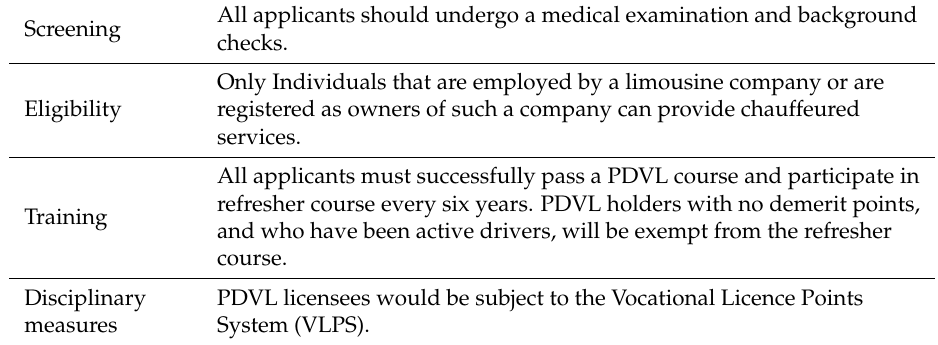
Table 3. The Private Hire Car Driver Vocational Licensing (PDVL) framework and Taxi Driver Vocational Licensing